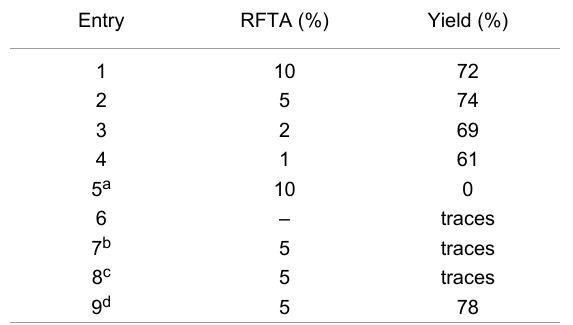
Table 1: Conditions and yields for the oxidation of 4,4’-dimethoxy- benzhydrol ( 1a